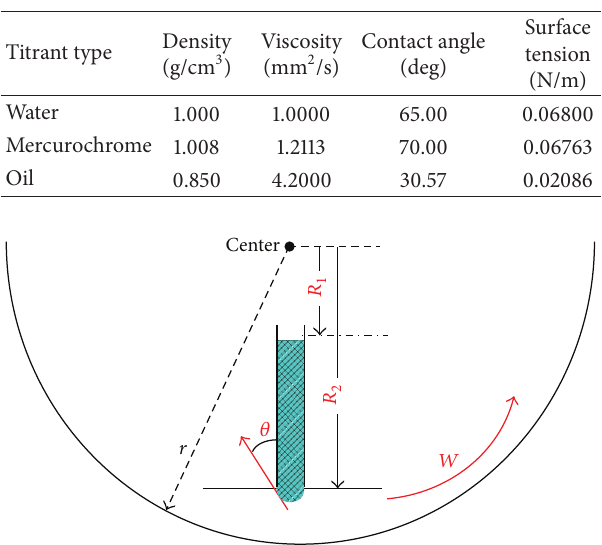
Figure 5: Fluid propulsion in centrifugal microfluidics